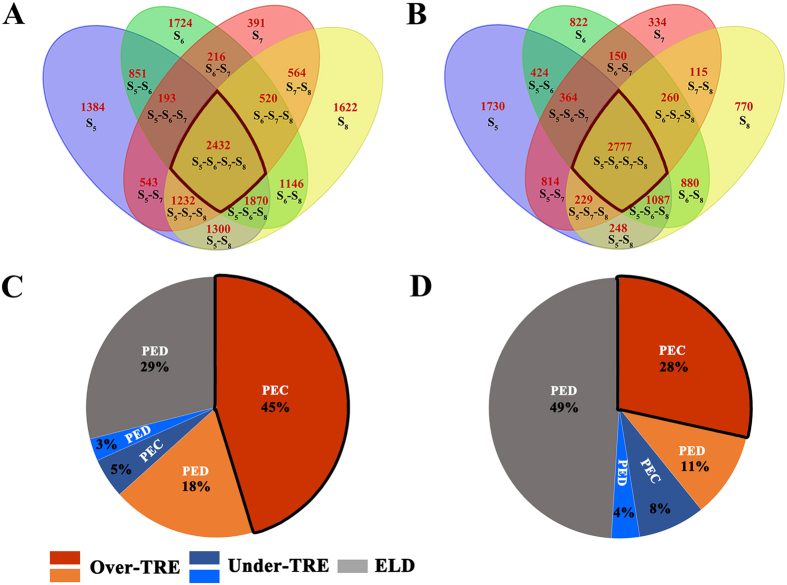
Numbers and proportions of the transgenerational conserved nonadditive expressed genes, and sources of those genes in AT2.(A,B) are the numbers of nonadditive expressing genes that are transgenerational conserved nonadditive expressed or no-transgenerational conserved nonadditive expressed genes in leaf and young-inflorescence of AT2, respectively. The four color ellipses represent the four early generations of AT2. There are two sources for transgenerational conserved nonadditive expressed genes, i.e., parental expression conserved genes (PEC) and parental expression different genes (PED). The PEC genes can exhibit only two patterns of nonadditive expression, i.e., over- or under-transgressive expression or TRE, while four patterns of nonadditive expression are possible for the PED genes, that is, apart from the two patterns of TRE, PED genes may also show higher or lower parental expression level dominance or ELD. The transgenerational conserved nonadditive expressed genes of both leaf (A) and young-inflorescence (B) can be further divided into several subclasses, as illustrated by pie charts (C,D), respectively.